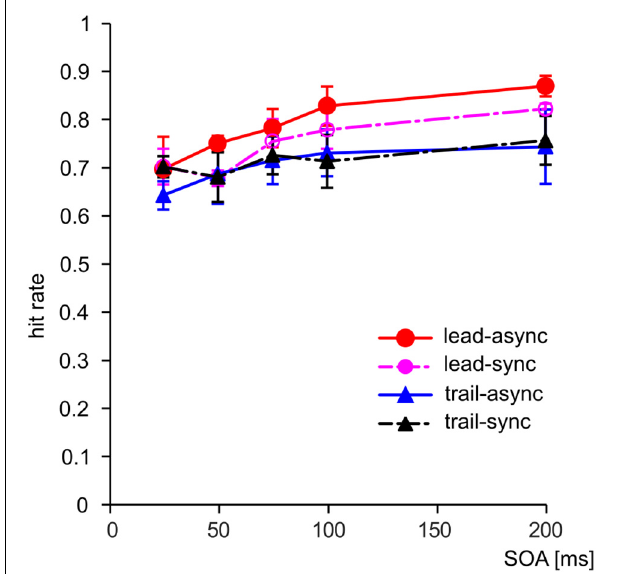
FIGURE 3 | The hit rate combined across sides (positive/negative SOAs) as a function of SOA. Error bars: Standard error of the mean. Color coding as in Figure 2